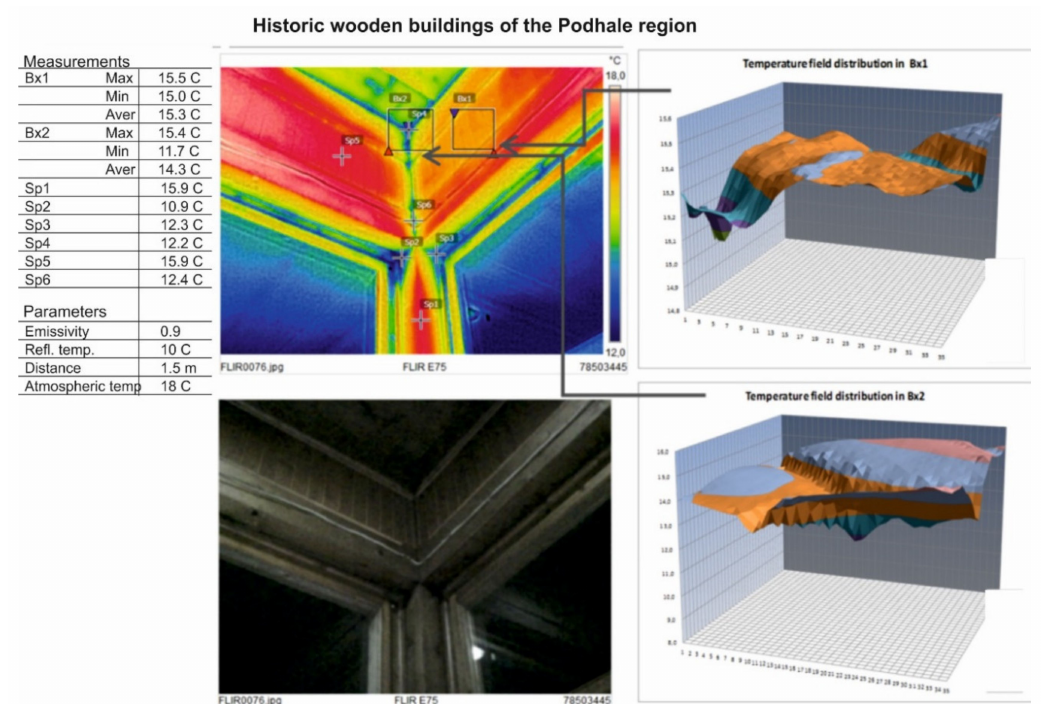
Figure 12. Precision thermogram along with points and temperature measurement fields and an additional temperature distribution field chart (B × 1 and B × 2).